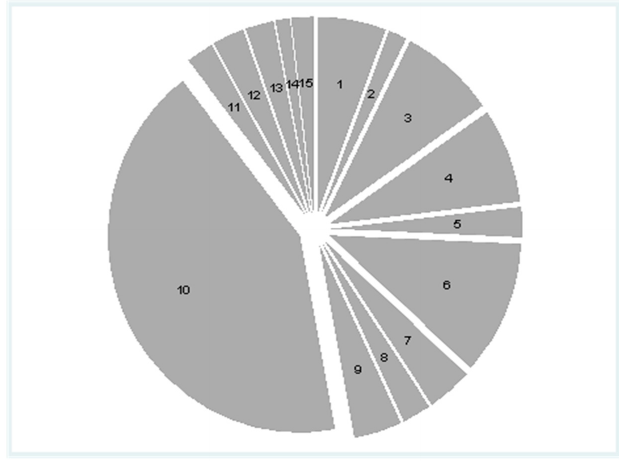
Figure 5. Gross value of production by industry groups.